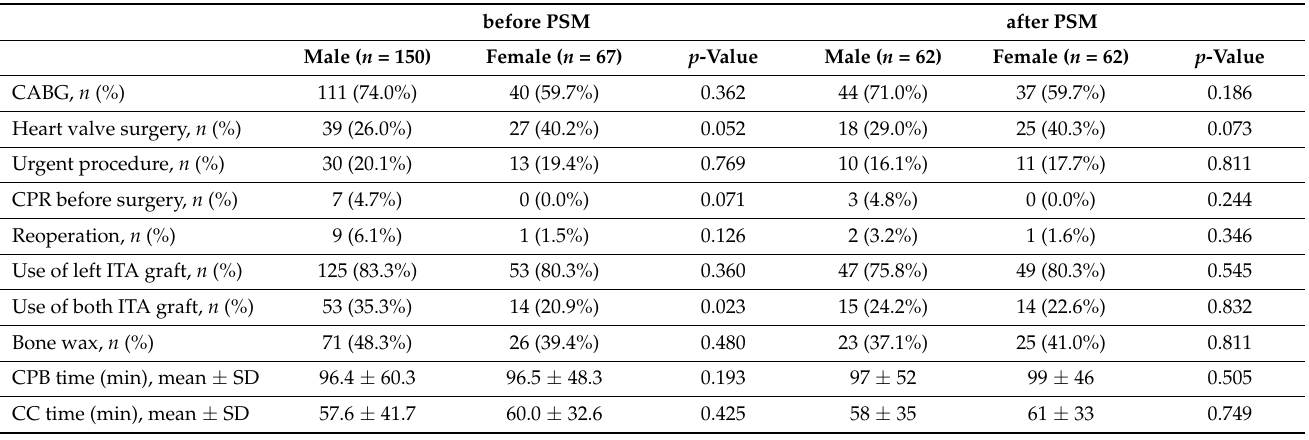
Table 2. Intraoperative